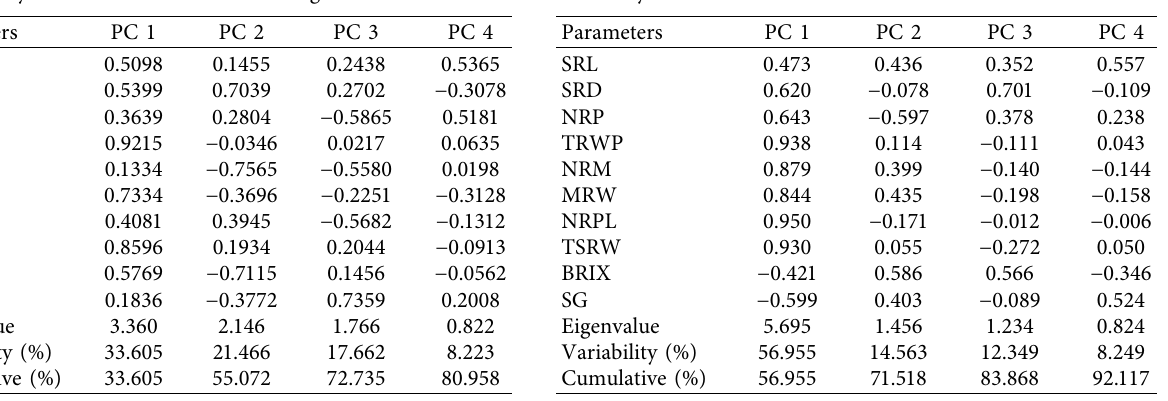
Table 4: Factor loadings, of agronomic trait markers, contributed to variability in PFSP at Cilembu Sumedang.